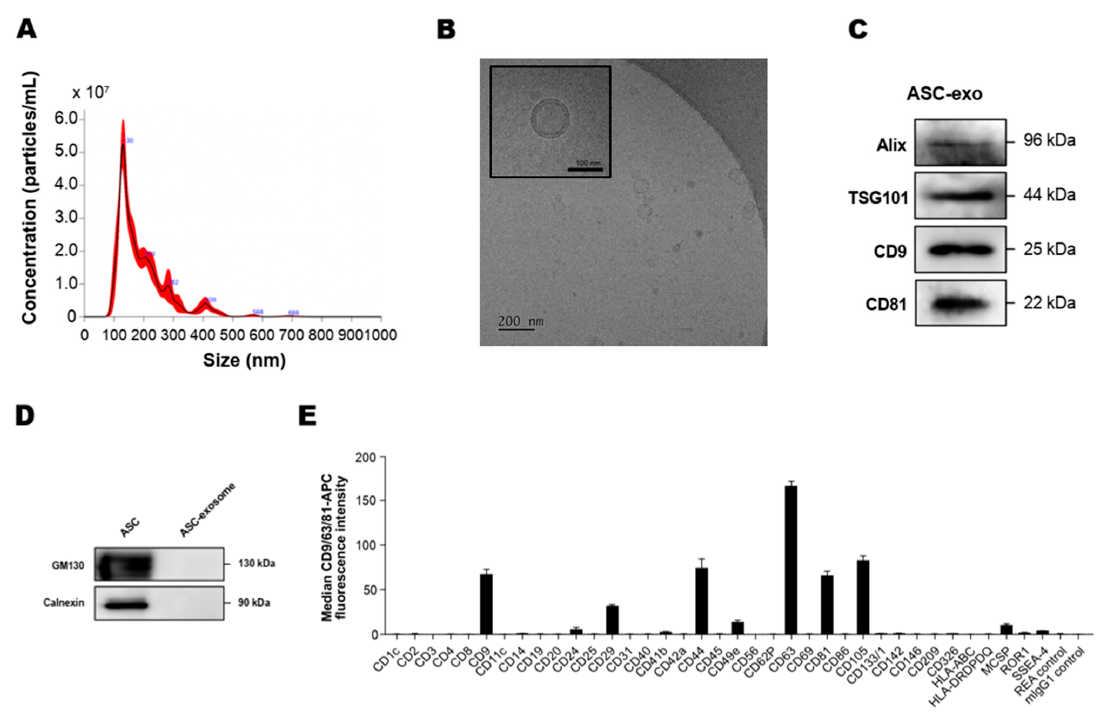
Figure 1. Characterization of adipose tissue-derived MSCs (ASC)-exosomes. ( A ) Representative histogram of particle concentration and size distribution of ASC-exosomes measured by nanoparticle tracking analysis (NTA). ( B ) Representative Cryo-TEM image of ASC-exosomes. Scale bar: 100 nm. ( C ) ASC-exosomes were analyzed using western blots for the presence of exosomal markers such as Alix, TSG101, CD9, and CD81. ( D ) ASC-exosomes were analyzed by western blotting for the negative markers of exosomes such as GM130 and Calnexin. Abbreviation: ASC, human adipose tissue-derived mesenchymal stem cell. ( E ) Surface signature of ASC-exosomes quantified by MACSPlex Exosome Kit (human) in conjunction with flow cytometry. Data indicate APC median signal intensities of ASC-exosomes incubated with the 39 capture beads and stained with a mixture of CD9-, CD63-, and CD81-APC antibodies. Background was corrected by subtraction of median fluorescence APC intensity. n = 10. MW, molecular weight.